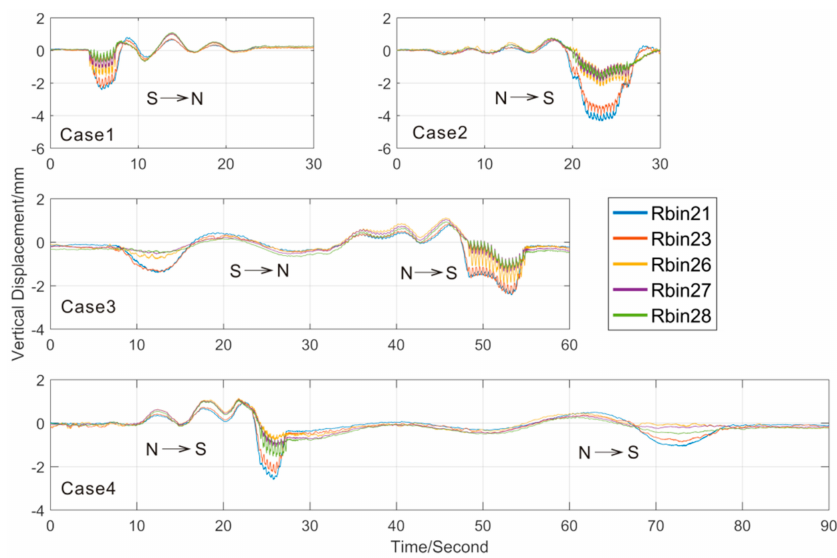
Figure 15. Vertical displacement time histories of the four loading cases.